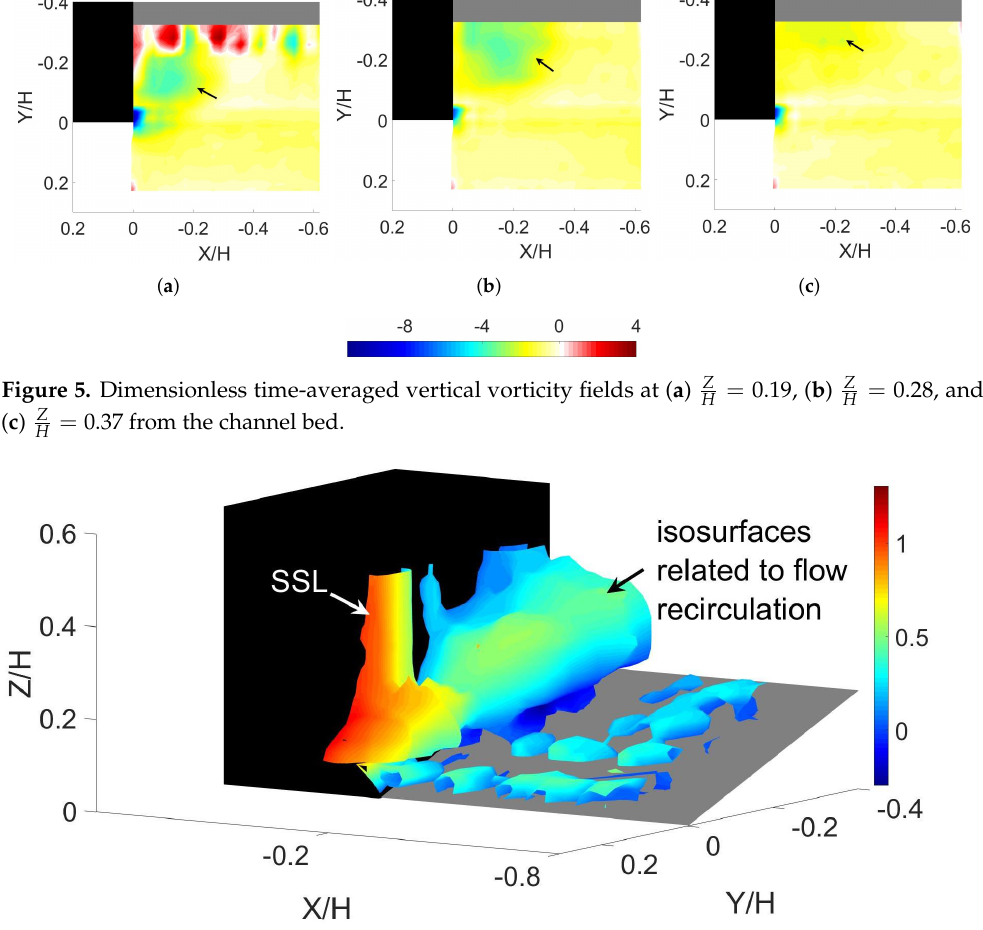
Figure 6. Isosurfaces of the dimensionless time-averaged horizontal vorticity field corresponding to the isovalue of −